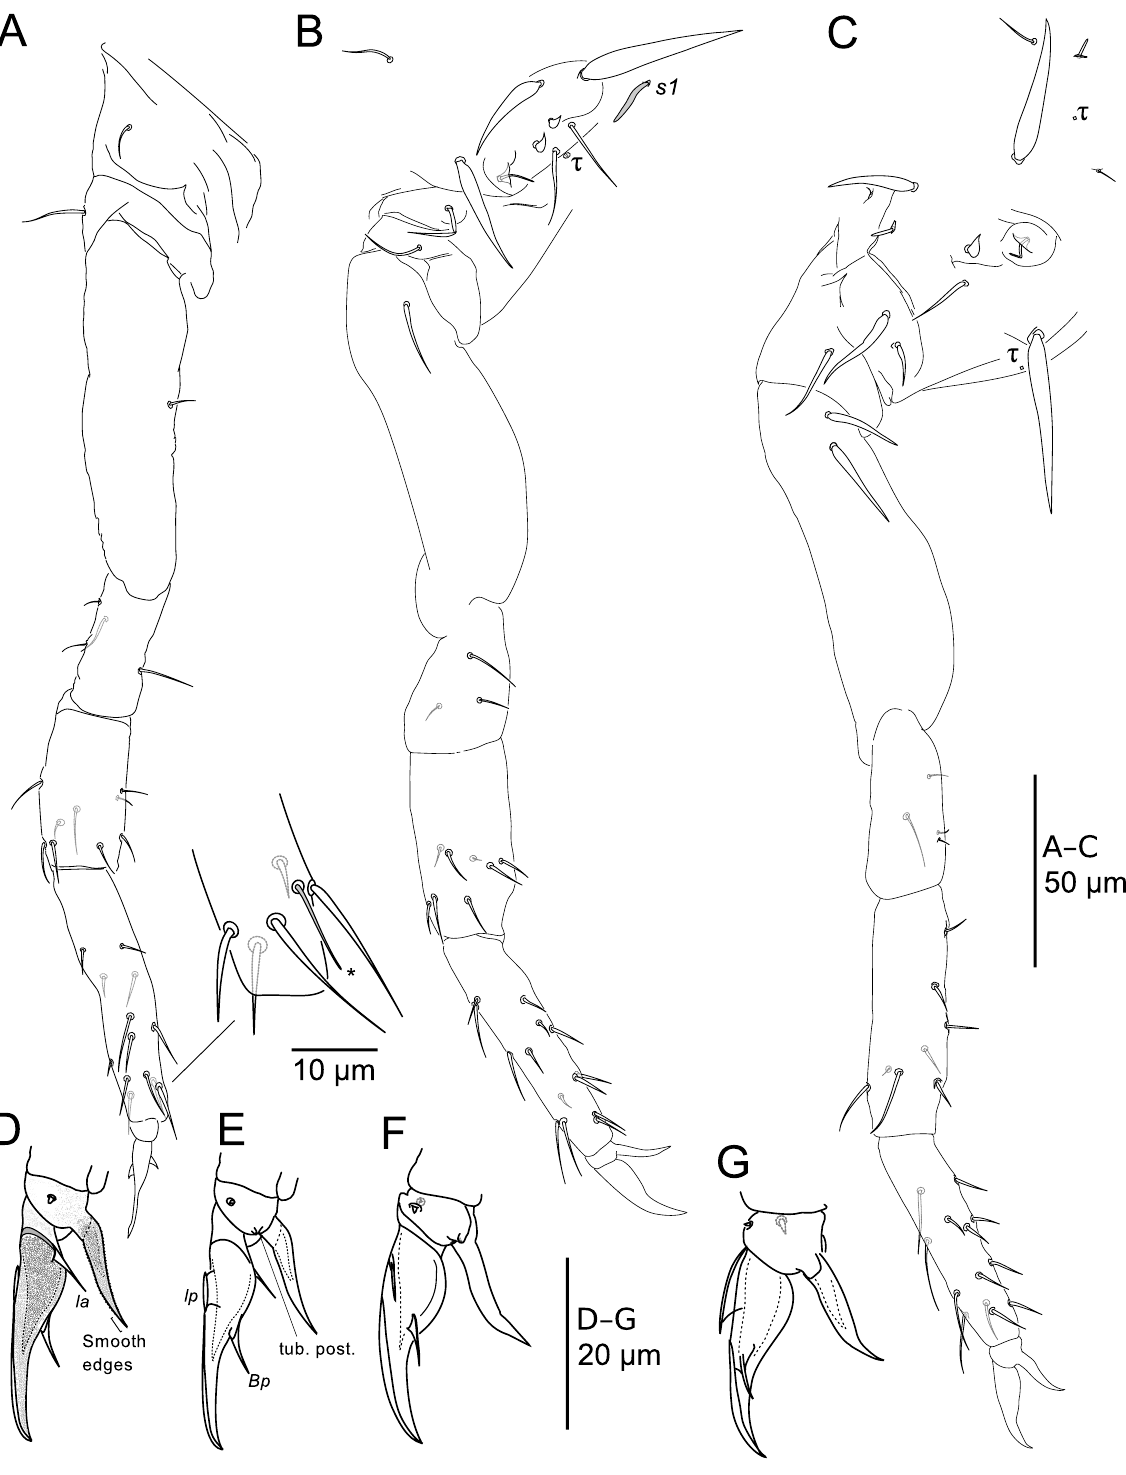
Fig. 5. Spinaethorax adamantis sp. nov. A–C . Chaetotaxy of legs. A . Leg I with focus on apical chaetae of tibiotarsus, asterisk indicates a special chaeta. B . Leg II (also with sf4 on Th. II precoxal area). C . Leg III (also with sf5 on Th. III precoxal area). D–G . Morphology of claws. D . Claw I posterior side. E . Claw I anterior side. F . Claw II posterior side. G . Claw III posterior